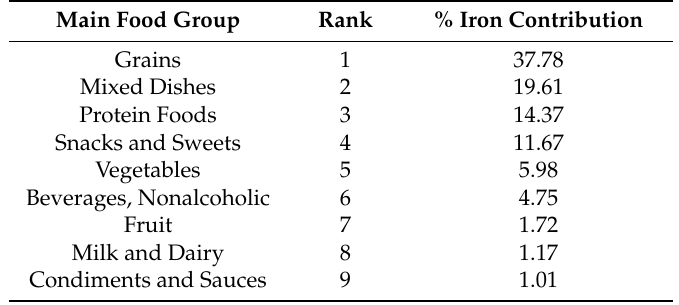
Table 8. Food sources of iron contribution in the total U.S. diet, adults ≥ 51 years old ( n = 4522; gender combined; daily intake data; NHANES 2011–2014; main food groups contributing <1.0% not reported; data are Day 1 intakes).